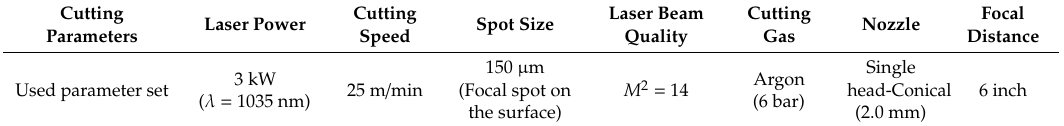
Table 1. Laser cutting parameters applied for Ti-6l-4V-ELI sheets on the TruDisk 5001 laser (Fa. TRUMPF-Series Tru Laser 7025).